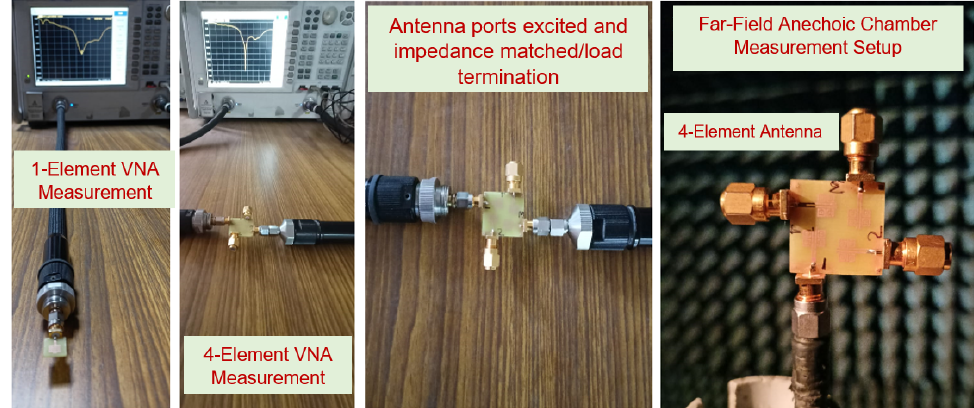
Figure 18. Experimental (measurement) setup of the fabricated one-element antenna and four- element antenna.